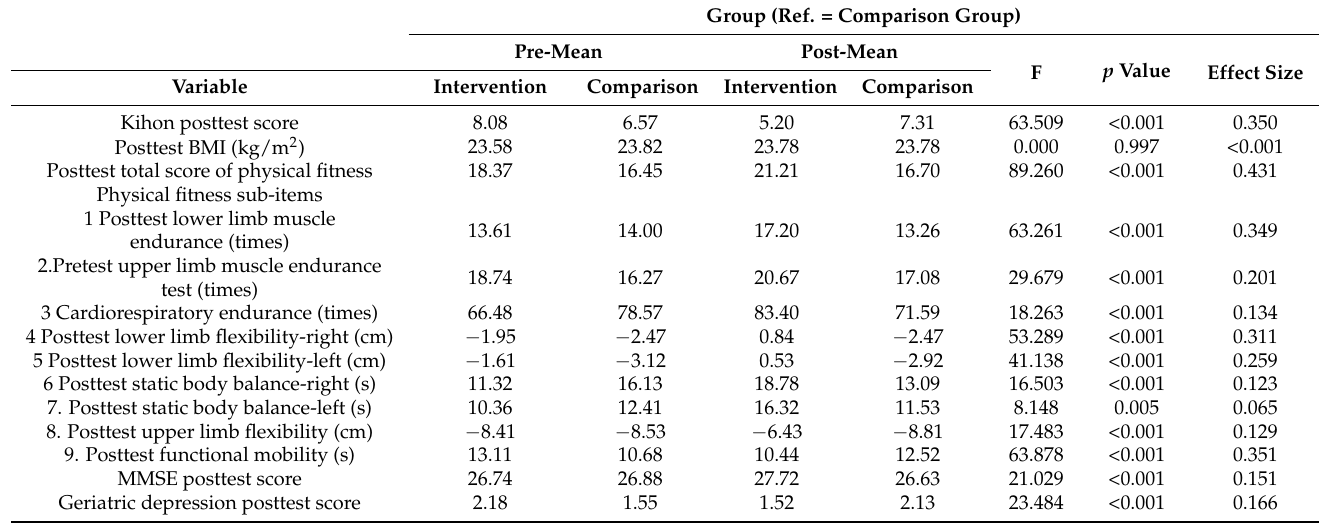
Table 3. Effects of music therapy on frailty, MMSE, BMI, physical fitness, and depression in the community-dwelling elders. Group (Ref. = Comparison Group) Pre-Mean Post-Mean F p Value Effect Size Variable Intervention Comparison Intervention Comparison Kihon posttest